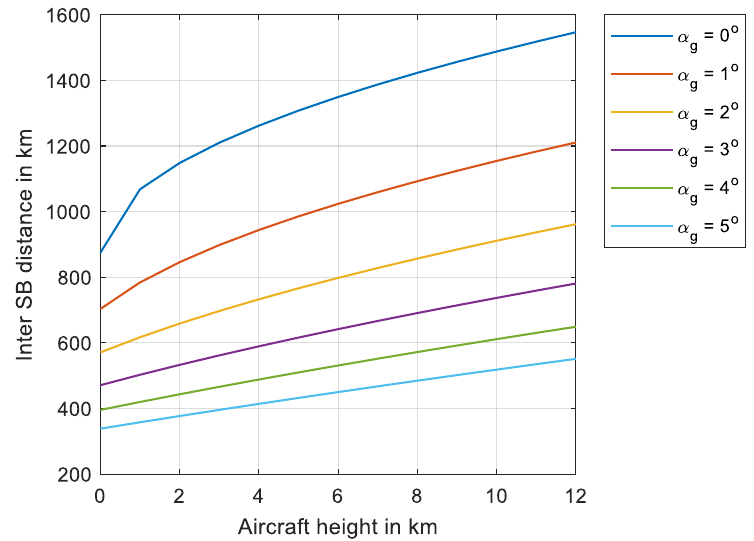
Figure 4. Variation of inter-SB distance with the aircraft height at different minimum elevation angles.